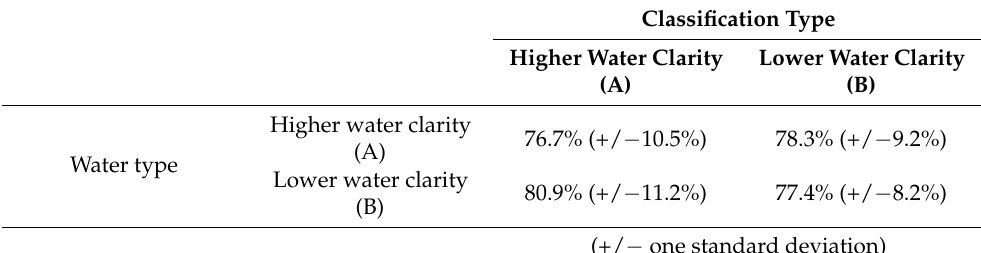
Table 6. Summary of average accuracy results by site (water) type and classification type (small-scale parameter = light or large-scale parameter =